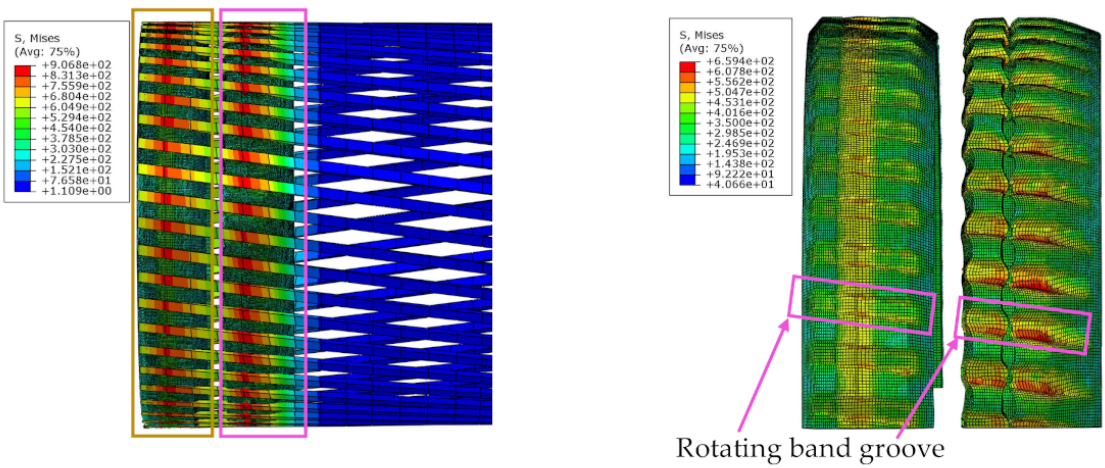
Figure 14. Appearance and stress distribution of the rotating bands and riflings in the second period.